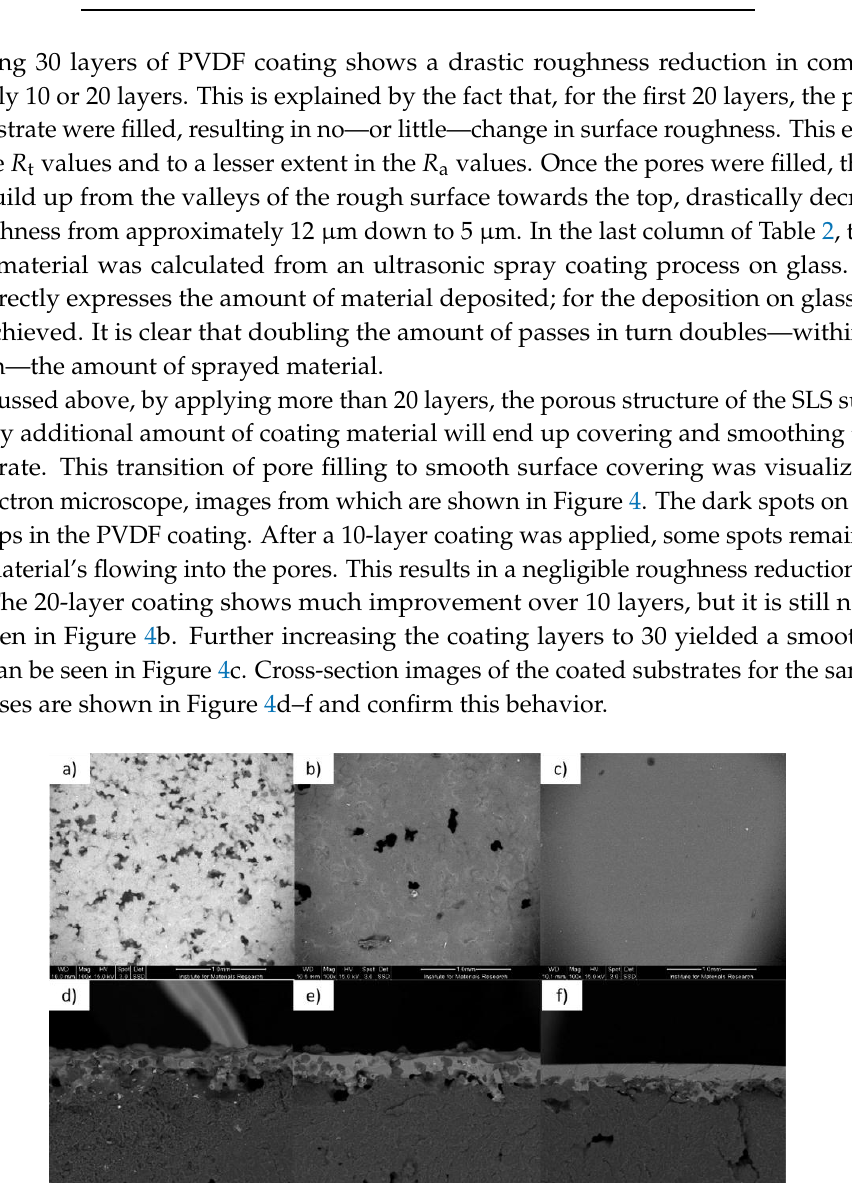
Table 2 . Roughness results for the initial substrate before coating and after applying 10, 20, and 30 layers of coating.